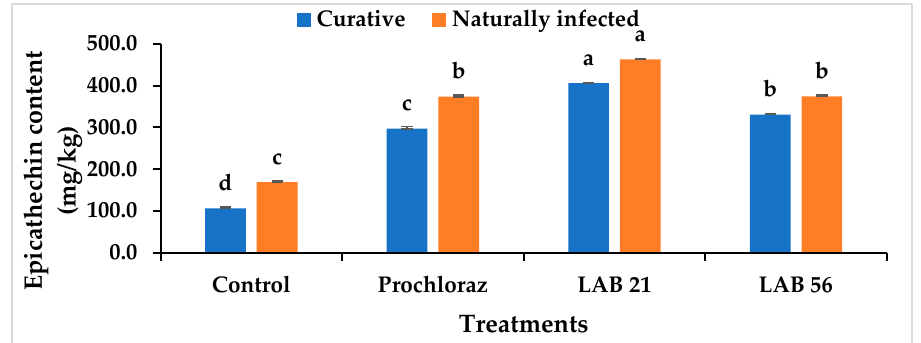
Figure 8. Effects of LAB strain treatments on the skin epicatechin content in inoculated and naturally infected avocado cv. “Fuerte” fruit. Similar columns with different letters were significantly different at the p ≤ 0.05 level. Keys: control—sterile distilled water; Prochloraz ® : positive control; LAB 21— Weissella cibaria 21; LAB 56— Leuconostoc pseudomesenteroides 56.